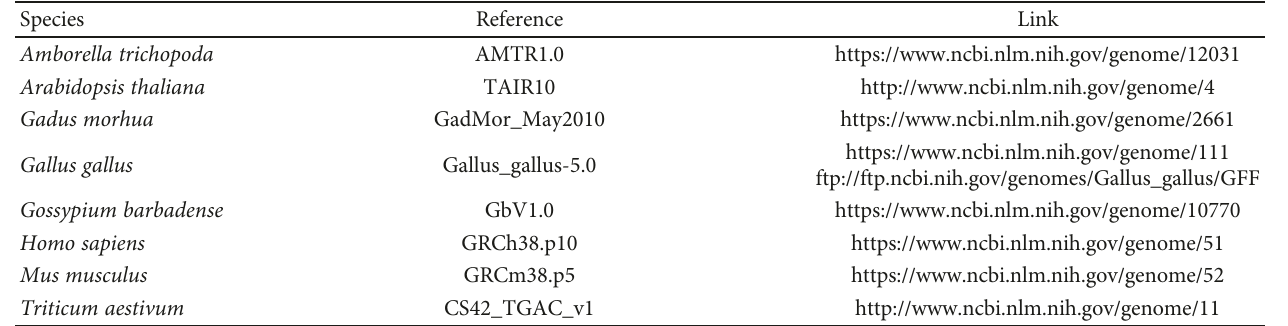
Table 1: The reference and annotation fi les for eight species.